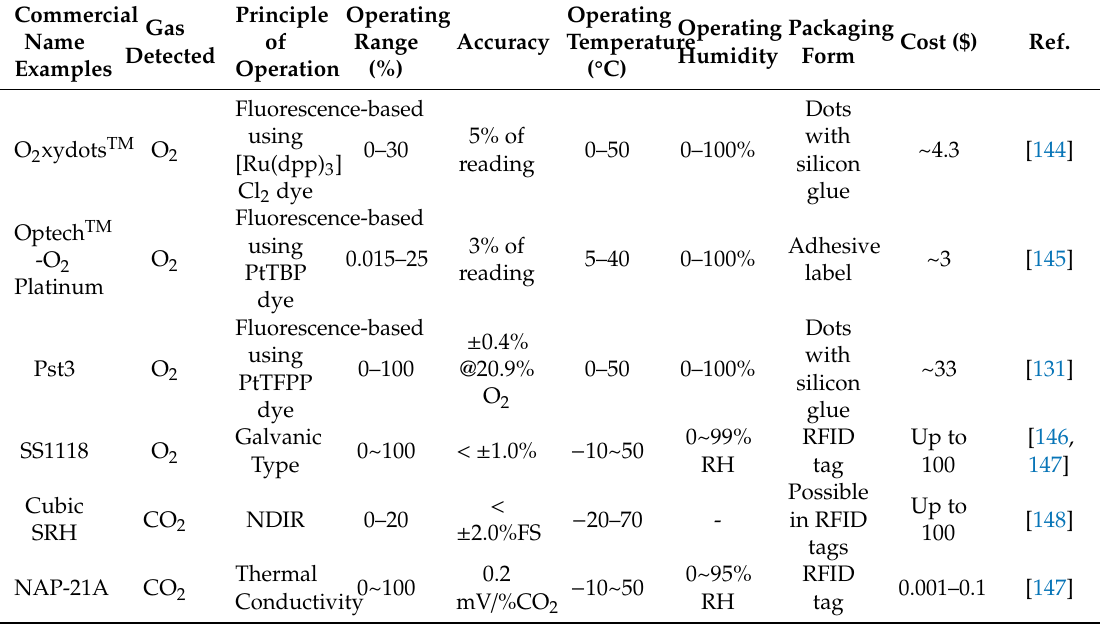
Table 4. Commercial O 2 and CO 2 sensors used in vegetable package